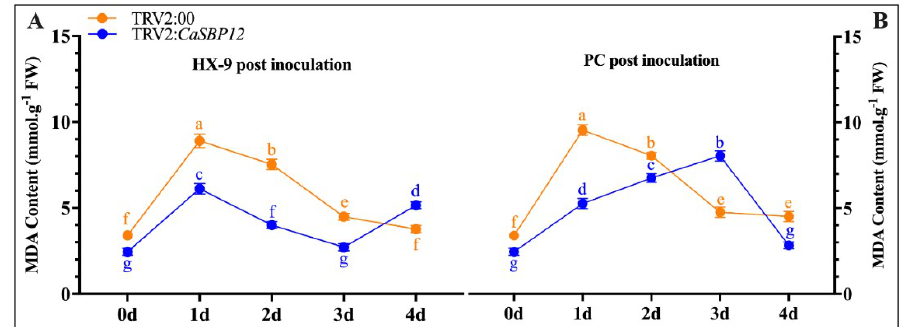
Figure 7. The malondialdehyde (MDA) content of the silenced and control plants after inoculation with P. capsici strains. ( A ) MDA content after inoculation with the HX-9 strain of P. capsici in silenced and control plants. ( B ) MDA content after inoculation with the PC strain of P. capsici in silenced and control plants. Bars with different lower-case letters indicate significant differences using the least significant difference (LSD) value ( p ≤ 0.05). Mean values and SEs for three replicates are shown.